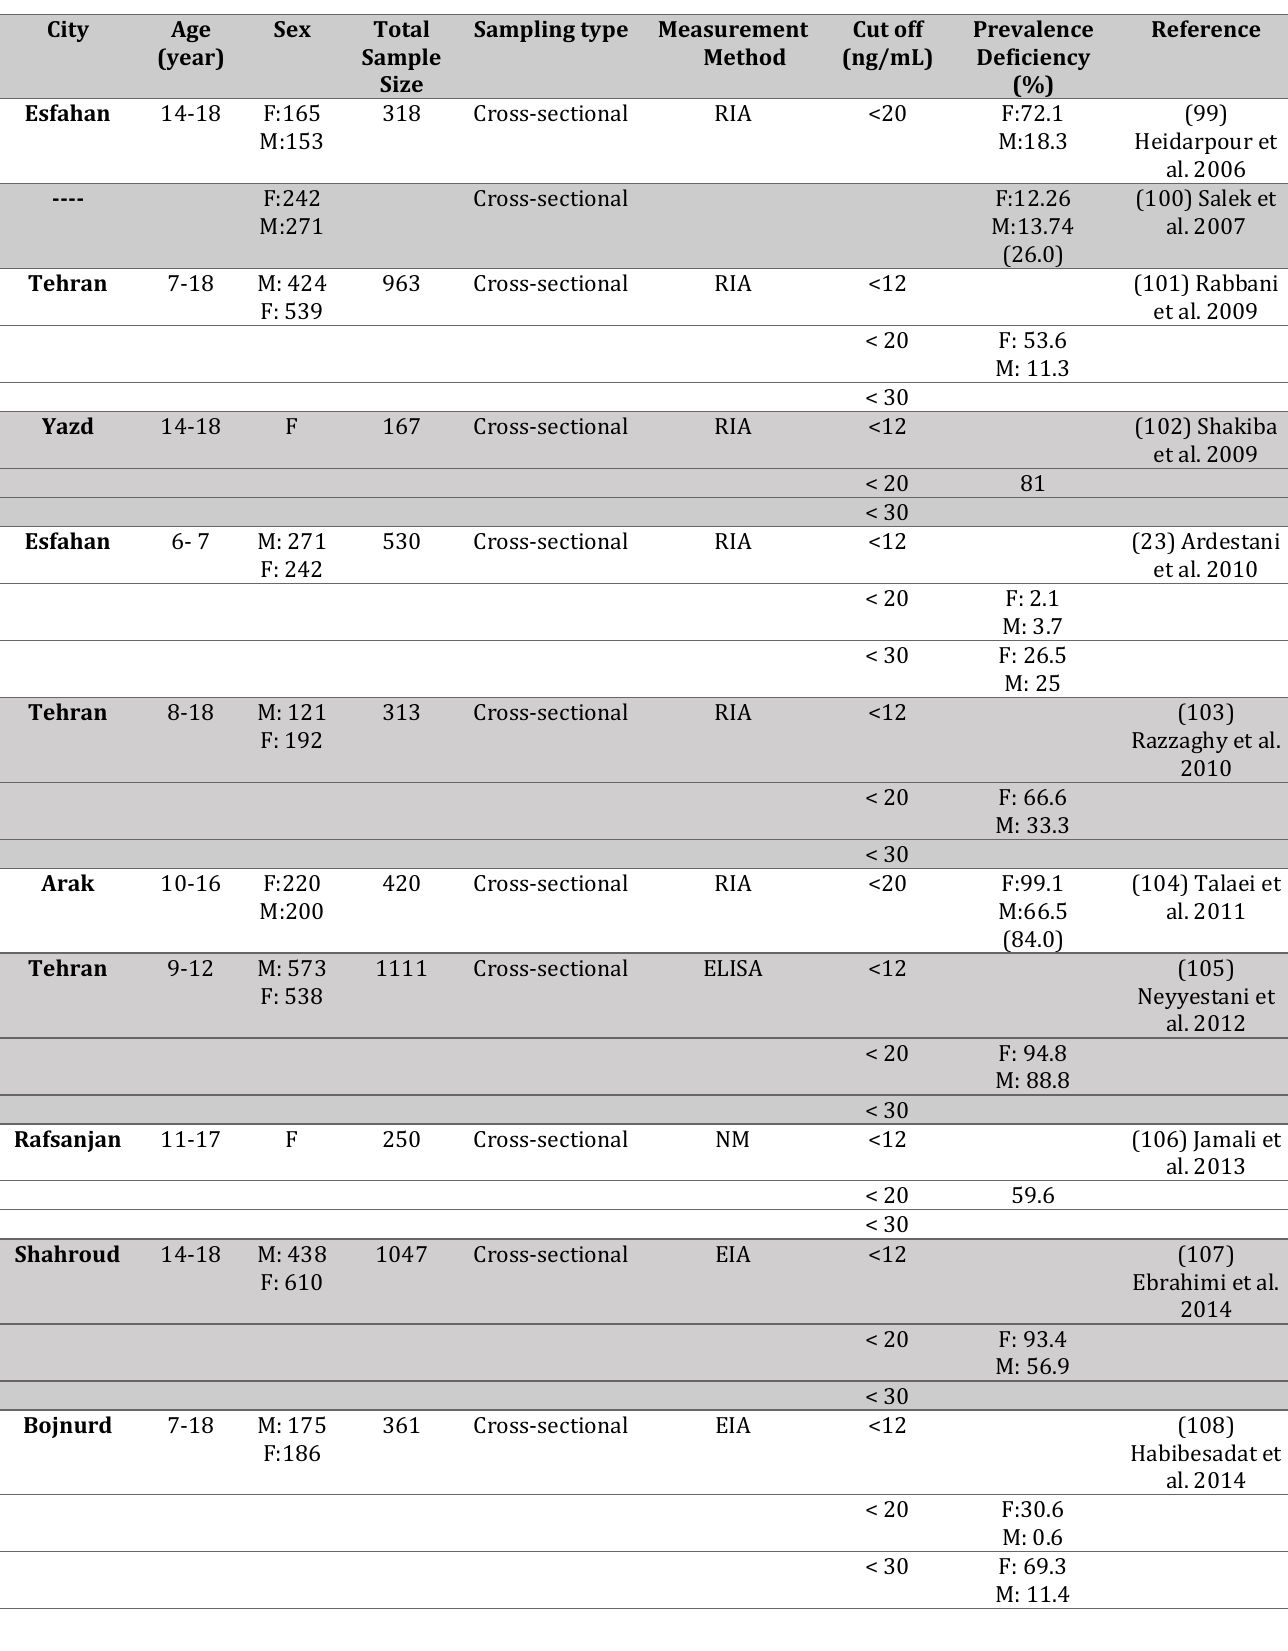
Table 3. Characteristic and main results for the prevalence of vitamin D deficiency or insufficiency in children and adolescents in